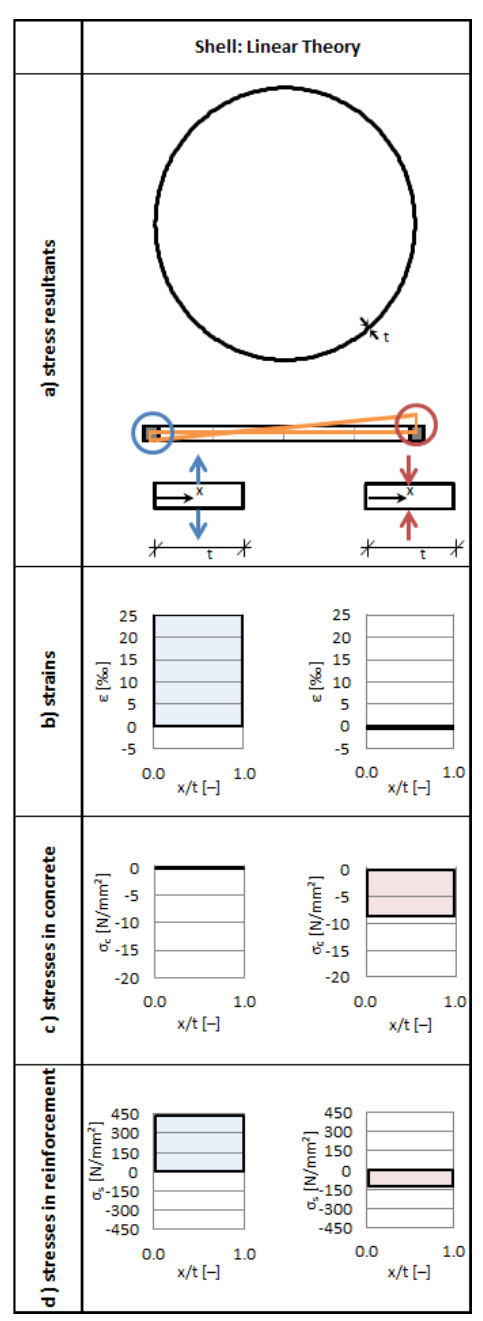
Figure 4. Design via beam theory for a specific wind load.